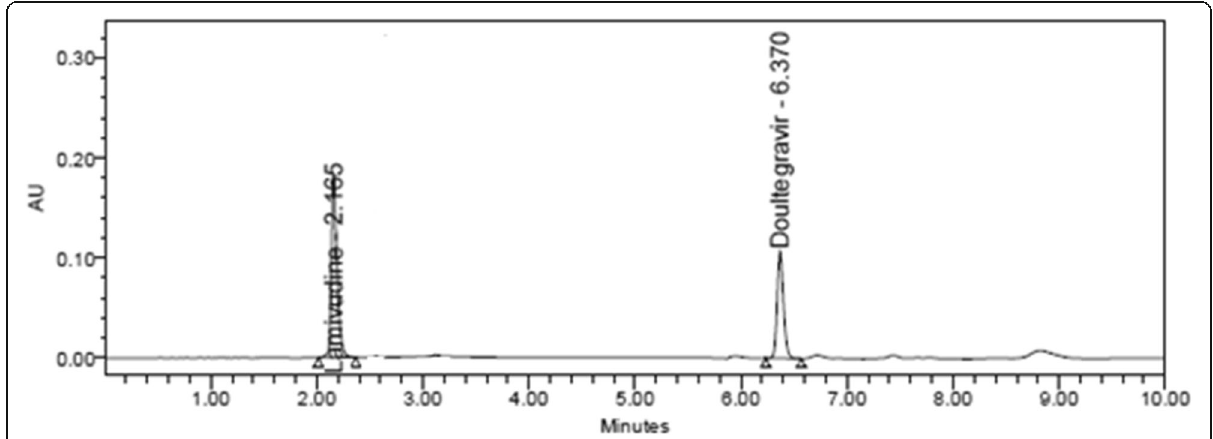
Fig. 5 Typical chromatogram of sample